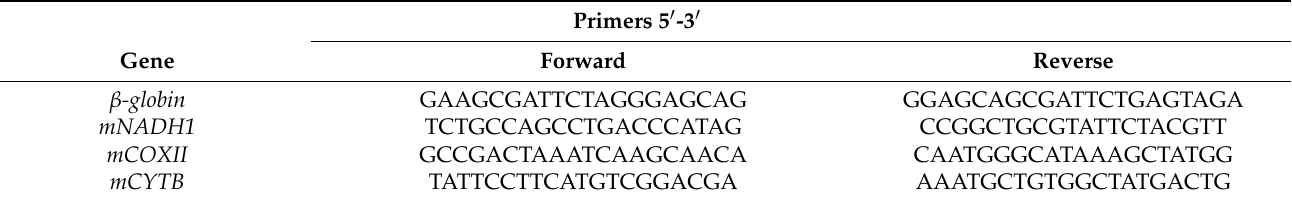
Table 3. Primer Sequences for mitocopy number